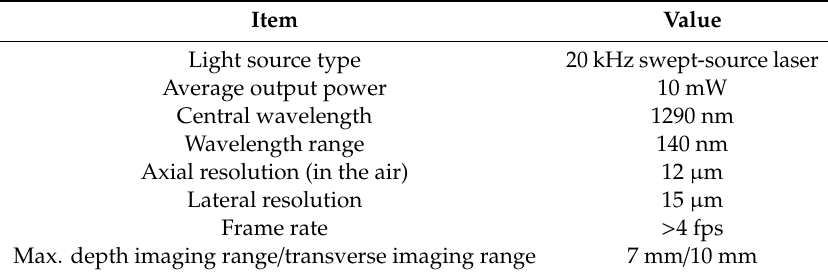
Table 2. Parameters of the spectroscopic (S)-OCT system.